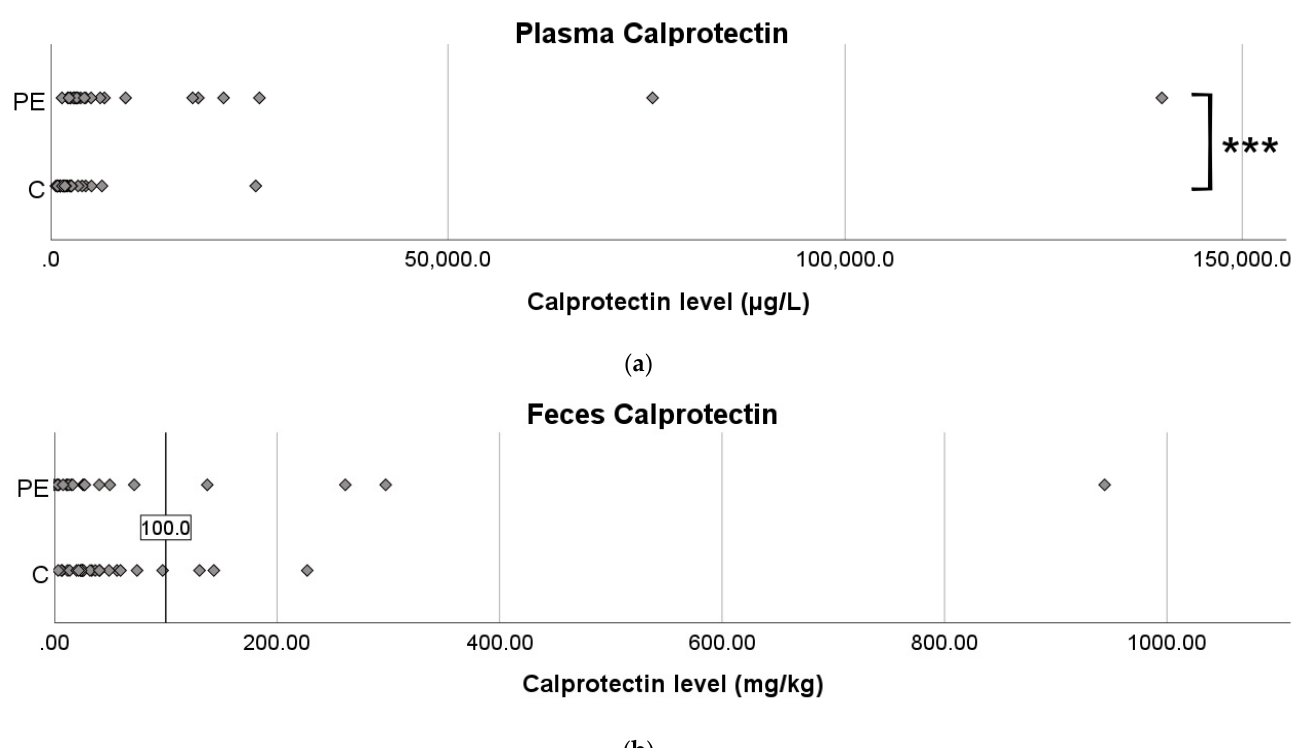
Figure 1. Plasma ( a ) and feces ( b ) calprotectin levels in controls vs. PE. ( a ) PE: N = 25, median 3764 µg/L, IQR 2897–13,639 µg/L; C: N = 28, median 1819 µg/L, IQR 1176–2612 µg/L. ( b ) PE: N = 20, median 21.0 mg/kg, IQR 8.4–66.2 mg/kg; C: N = 26, median 29.1 mg/kg, IQR 21.2–56.9 mg/kg. The line indicates the upper normal reference level for fecal calprotectin. Mann–Whitney U-test for significance, *** p < 0.001.